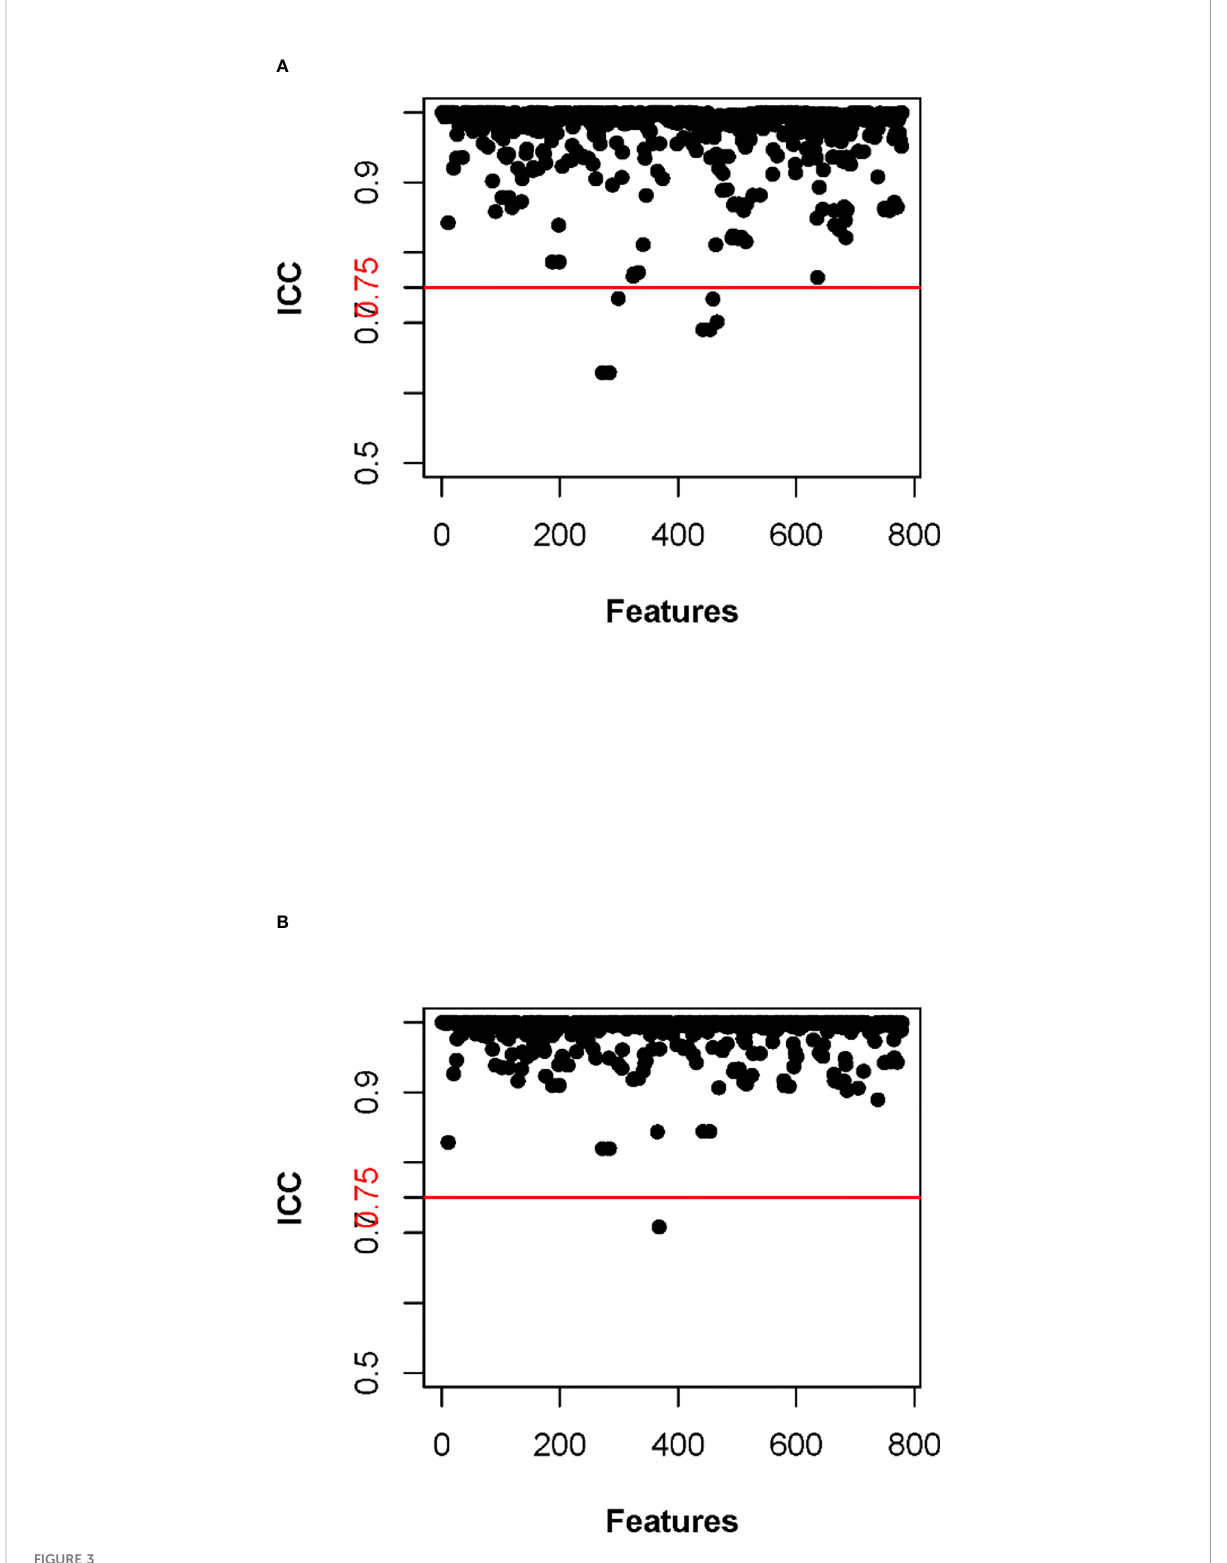
FIGURE 3 Inter-class correlation coef fi cient (ICC) of inter-observers (A) and intra-observer (B)